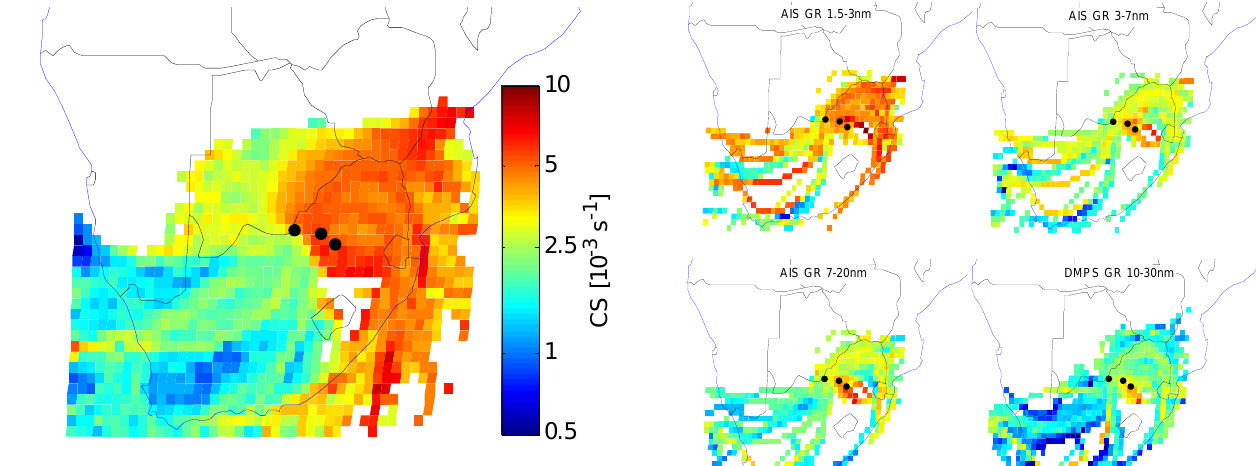
Fig. 15. The source areas of condensation sink. The black dots on the map represent (from left to right) Botsalano, Rustenburg and Johannesburg.